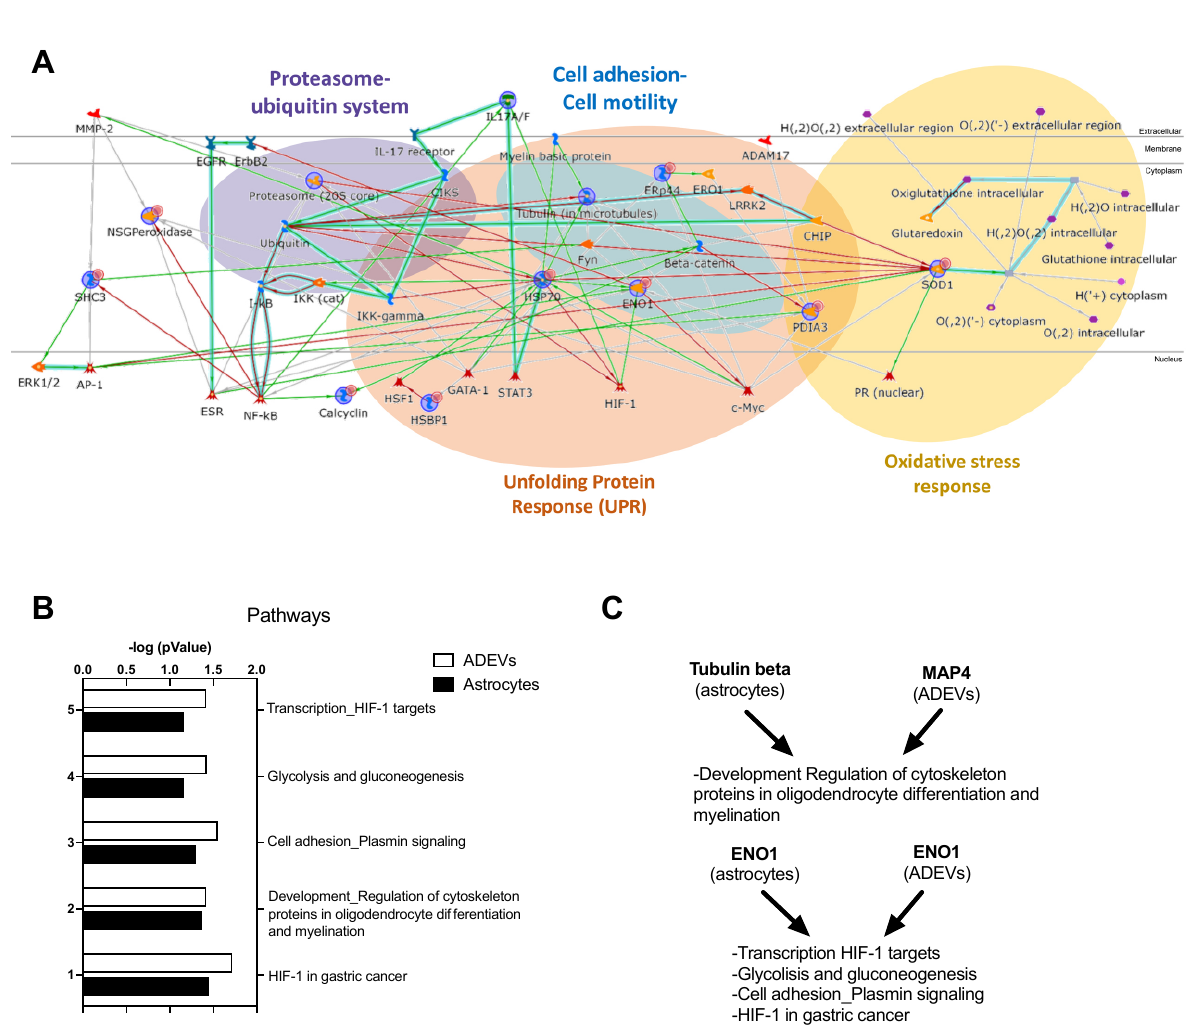
Figure 4. Protein network and pathways influenced by Rai in astrocytes and ADEVs. ( A ) Protein network analysis by using all the proteomic data obtained in WT astrocytes and ADEVs and those obtained in Rai −/− astrocytes and Rai −/− ADEVs. Proteasome (20 S core), HSP70, ENOA, and SOD1 are central functional hubs; ( B ) Pathway analysis comparison of the differential proteins found in astrocytes and ADEVs; ( C ) Association of differential proteins to the molecular pathways resulting from pathway analysis comparison of astrocytes and ADEVs.